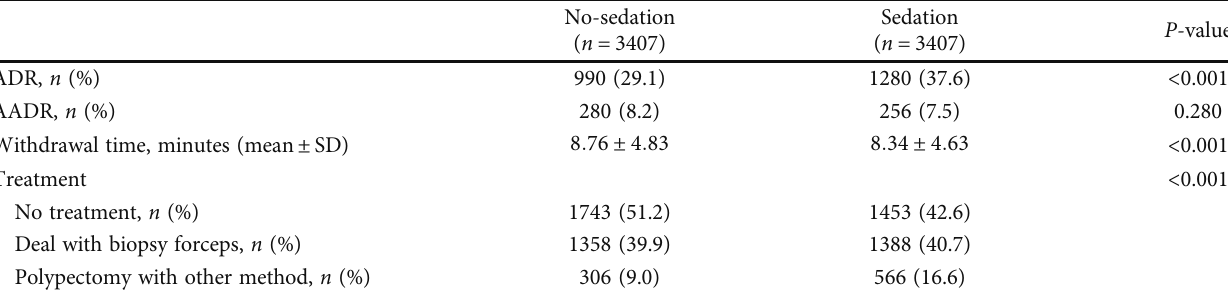
Table 6: Outcome comparison between sedation and no-sedation groups after PSM.